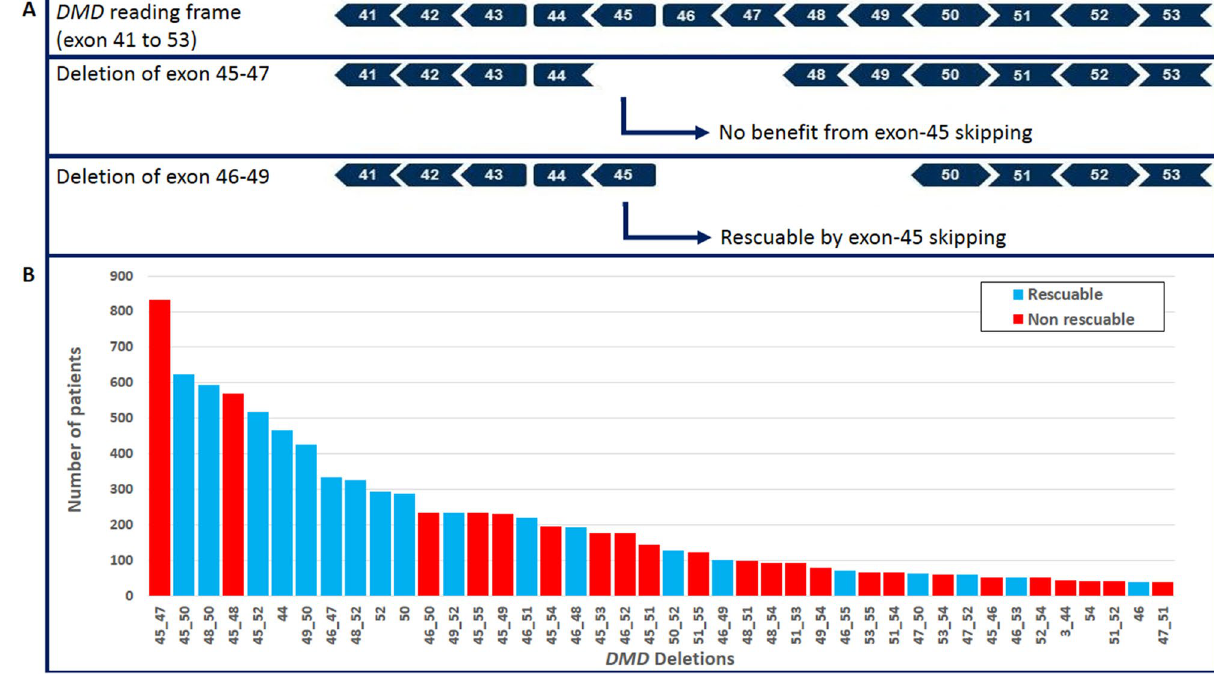
Figure 1. ( A ) Reading frame from exons 41 to 53 of DMD gene (upper frame). Example of the in-frame deletion of exons 45–47, which cannot benefit from exon-45 skipping (central frame). Example of the out-of- frame deletion of exons 46–49, which is amenable to exon-45 skipping (lower frame). ( B ) Number of patients with a large deletion (≥ 1 exon) covering at least one flanked exon reported in LOVD-DMD database. Deletions involving 35 or more patients are shown. Blue-bars point the deletions rescuable to either single exon-51, exon- 53 or exon-45 skipping, red-bars correspond to deletion not rescuable by the aforementioned therapies. Number of patients that would benefit from either Number of patients exon 45, 51 or 53 skipping (%) Entries reported in database